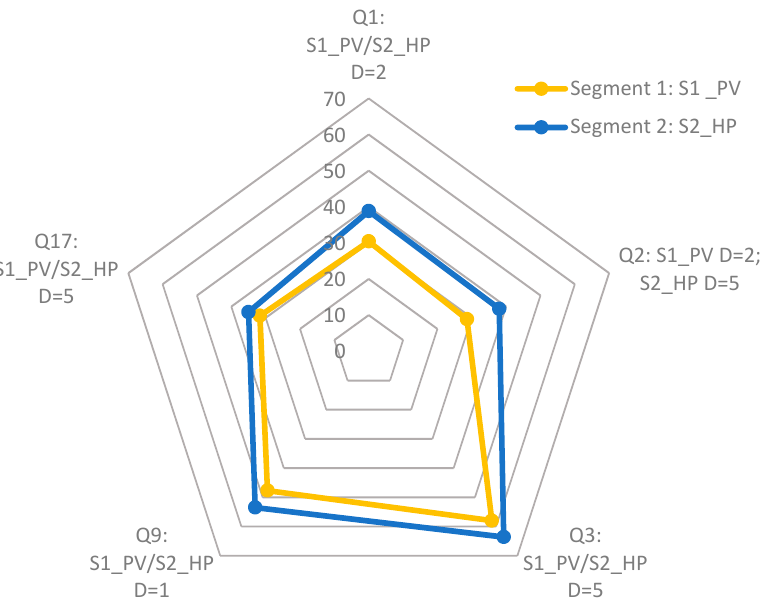
Figure 4. Prosumer behaviors related to the reduction in electricity consumption. Source: own research.